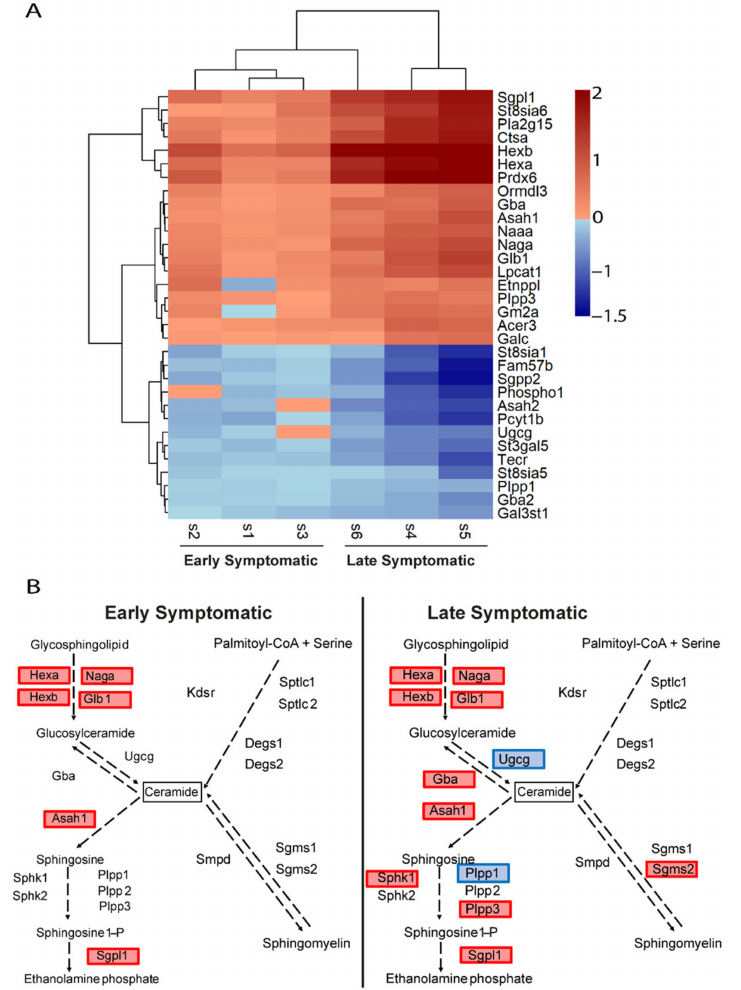
Figure 7. Comparative transcriptional alterations in glycosphingolipids and ceramides metabolic pathways in the spinal cord of SOD1 mice at early and late symptomatic disease stages. ( A ) The heatmap of the combination of the six transcriptomic studies (three early symptomatic and three late symptomatic) shows the expression level of the altered genes that participate in the glycosphin- golipids metabolic pathways. The heatmap colours indicate the expression levels by the log2-fold- change. Each column represents an individual RNA-seq study, and each row represents one gene. ( B ) The sphingolipids and ceramides biosynthesis pathways are represented, comparing the results from the Early MA and the Late MA. Coloured genes indicate that the gene was significantly altered in the meta-analysis. Blue indicates downregulation and red indicates